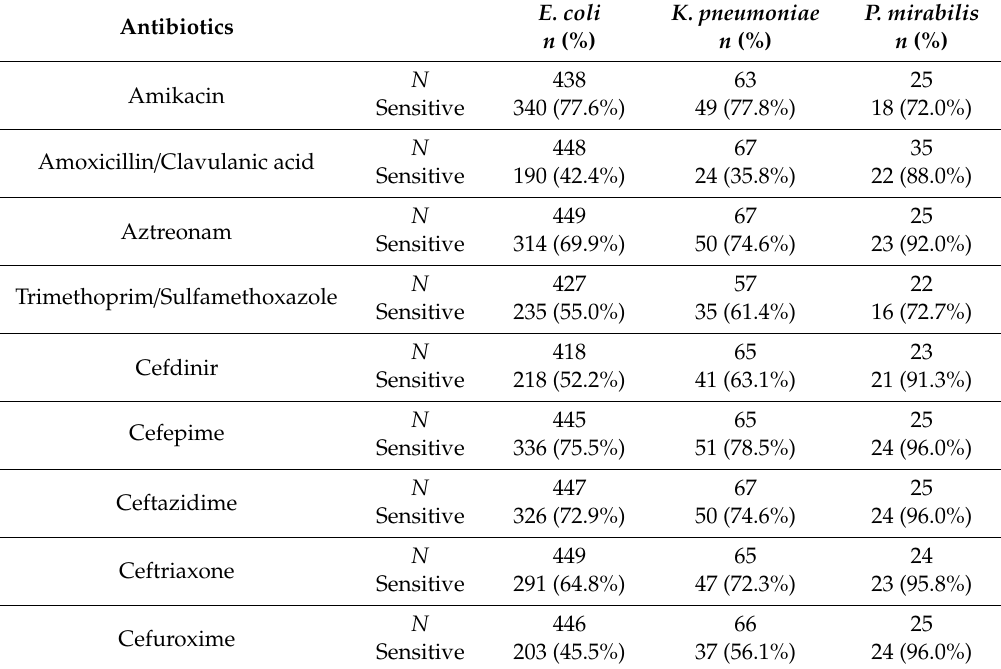
Table 6. Antibiotic susceptibility profiles of the three studied